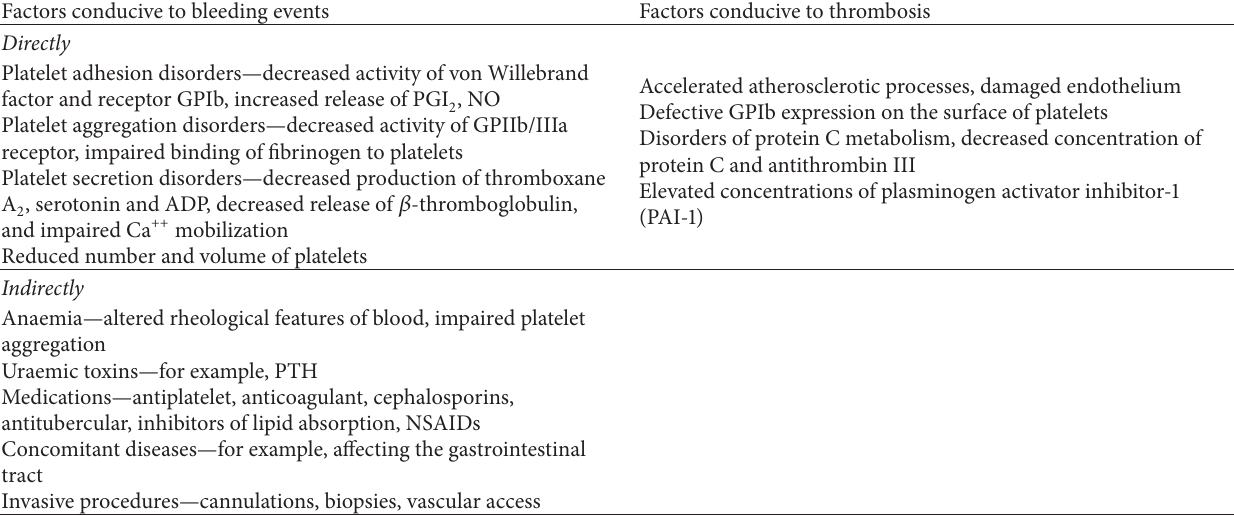
Table 1: Factors conducive to coagulation disorders in patients with end-stage renal disease and receiving haemodialysis [8–13]. Factors conducive to bleeding